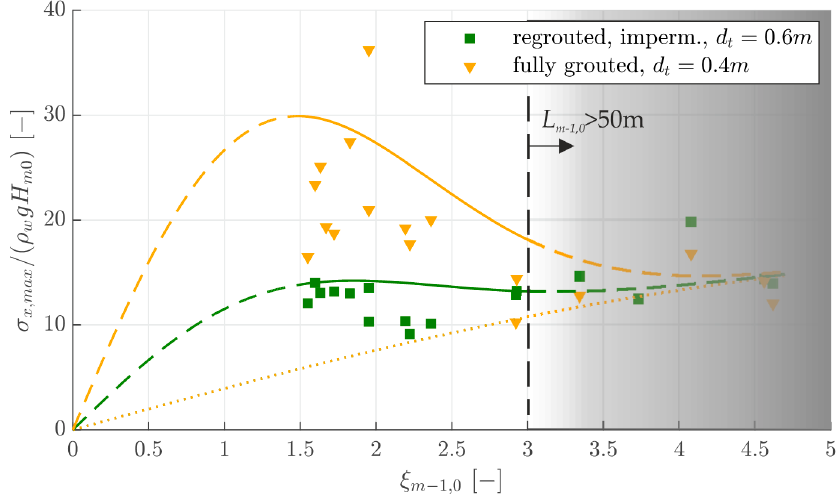
Figure 9. Maximum relative tensile bending stress σ x,max /( ρ w gH m 0 ) dependent on the surf similarity parameter ξ m − 1 , 0 with enveloping functions (impermeable, regrouted and fully grouted MGRR, parameter combination 1). The quasi ‐ static component of the relative bending stress from Equation (9) is shown as a dotted line. The dashed line for illustration shows the enveloping functions for surf similarity parameters for which no experimental data is available (after [28]).